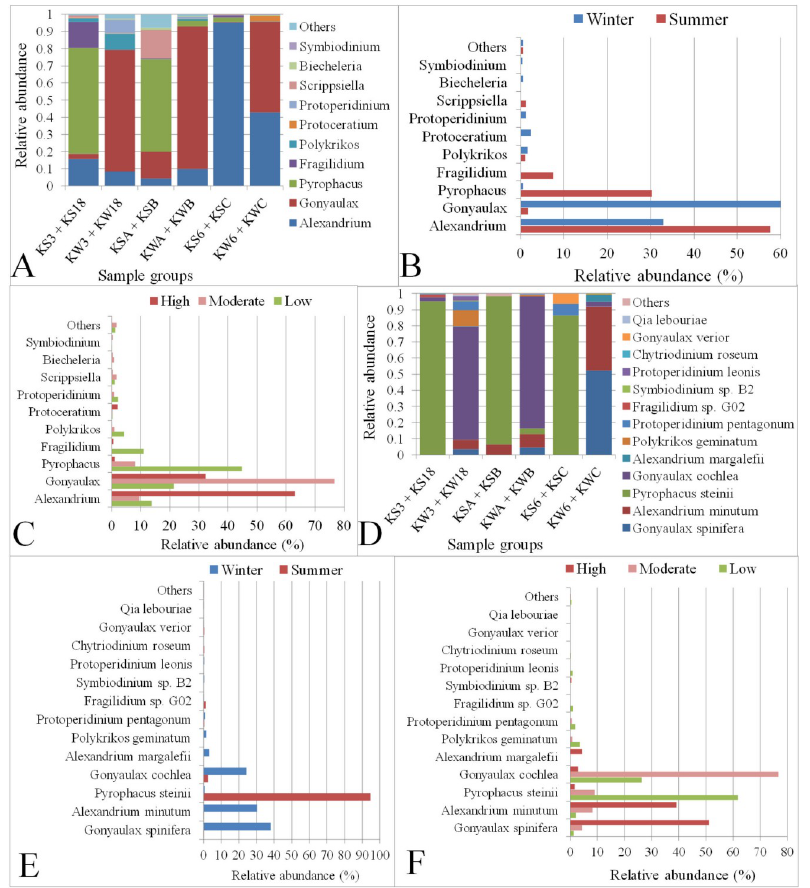
Fig 9. Relative abundance of Dinoflagellata genera and species in Kuwait Bay. A, B and C: Abundances of Dinoflagellata genera in samples grouped based on sampling station, season, and anthropogenic activity level, respectively. D, E and F: Abundances of Dinoflagellata species in samples grouped based on sampling station, season and anthropogenic activity levels, respectively. The term “Others” on the Y-axis includes genera with an abundance of < 0.1% in B and C or species < 0.05% in E and F. KS3 + KS18: Samples collected in summer from stations with low anthropogenic activity levels; KW3 + KW18: Samples collected in winter from stations with low anthropogenic activity levels; KSA + KSB: Samples collected in summer from stations with moderate anthropogenic activity levels; KWA + KWB: Samples collected in winter from stations with moderate anthropogenic activity levels; KS6 + KSC: Summer- collected samples from stations with high anthropogenic activity levels; KW6 + KWC: Winter-collected samples from stations with high anthropogenic activity levels.